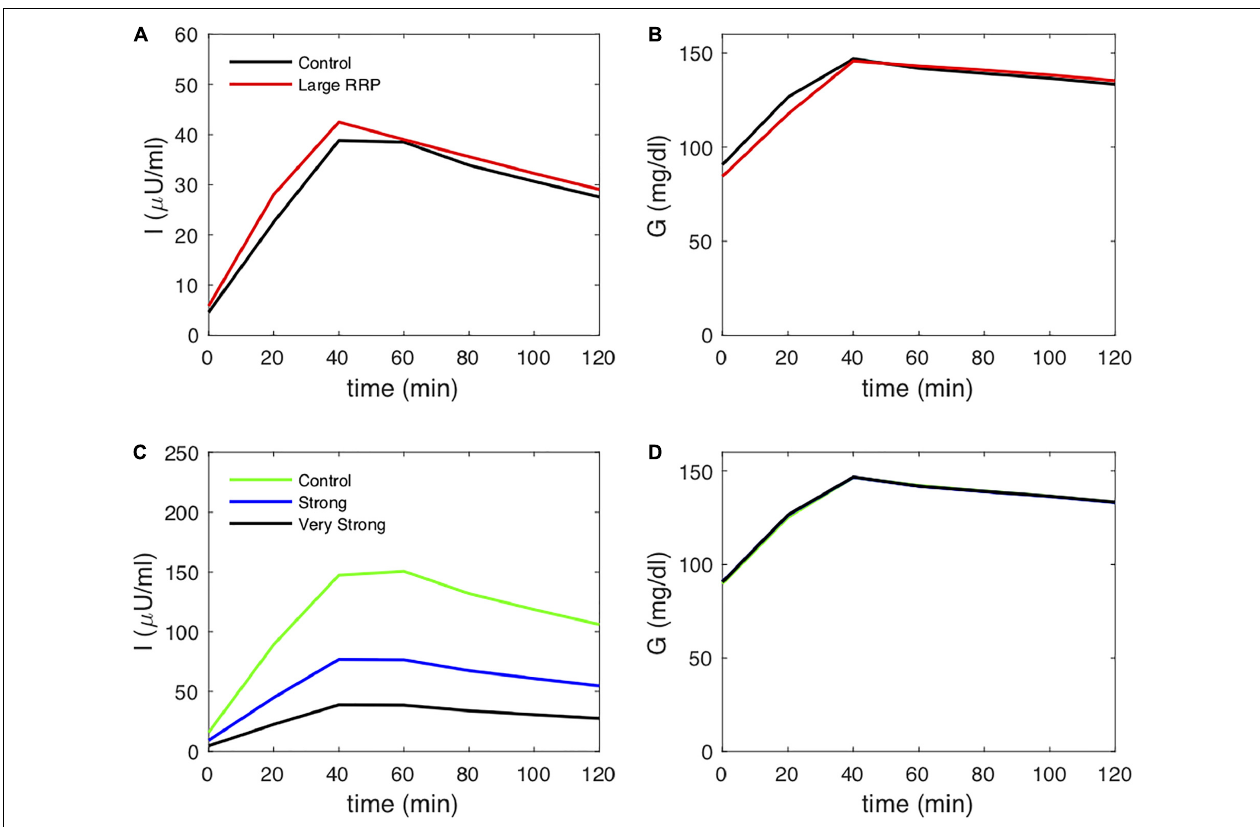
FIGURE 8 | Insulin (A) and glucose (B) during OGTTs simulated with the synthetic model, using the parameters of Figure 2 (increased RRP case) but with incretin effect included (larger values of G F , max , and G F , b in Eq. 7 and r 0 2 in Eq. 8). Insulin (C) and glucose (D) during OGTTs simulated with the synthetic model, using the parameters of Figure 6 but with incretin effect